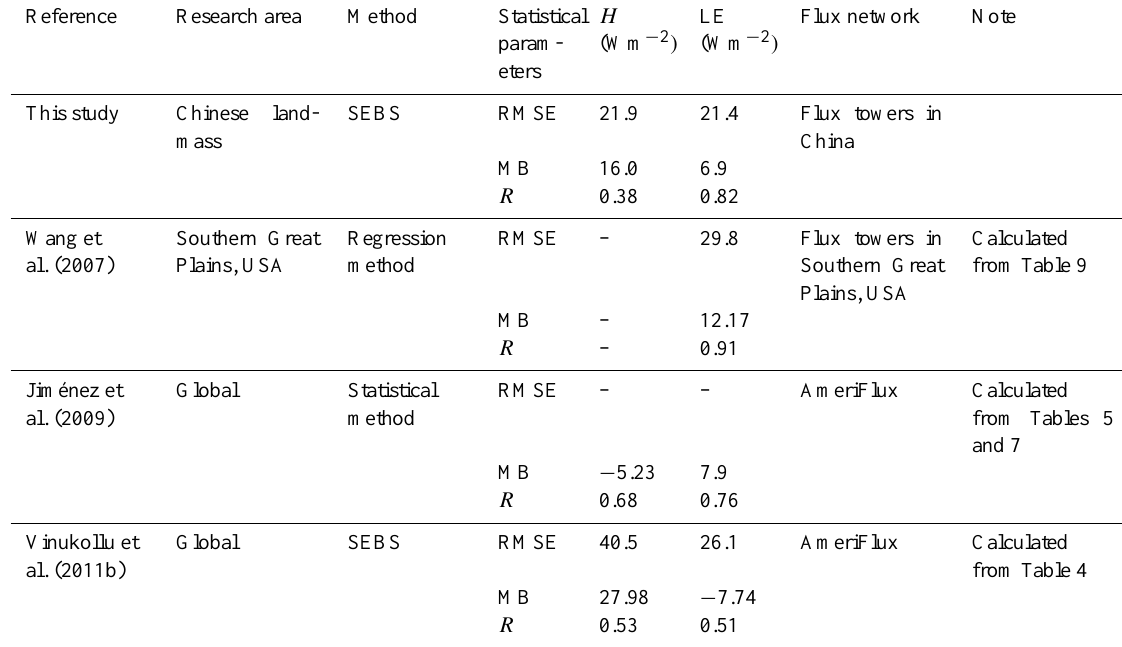
Table 4. Comparison of statistical values reported in similar